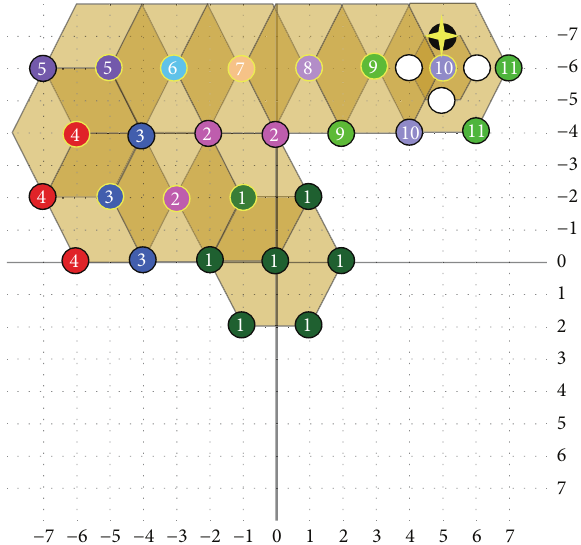
Figure 15: The proposed algorithm based on hexagon-based using genetic